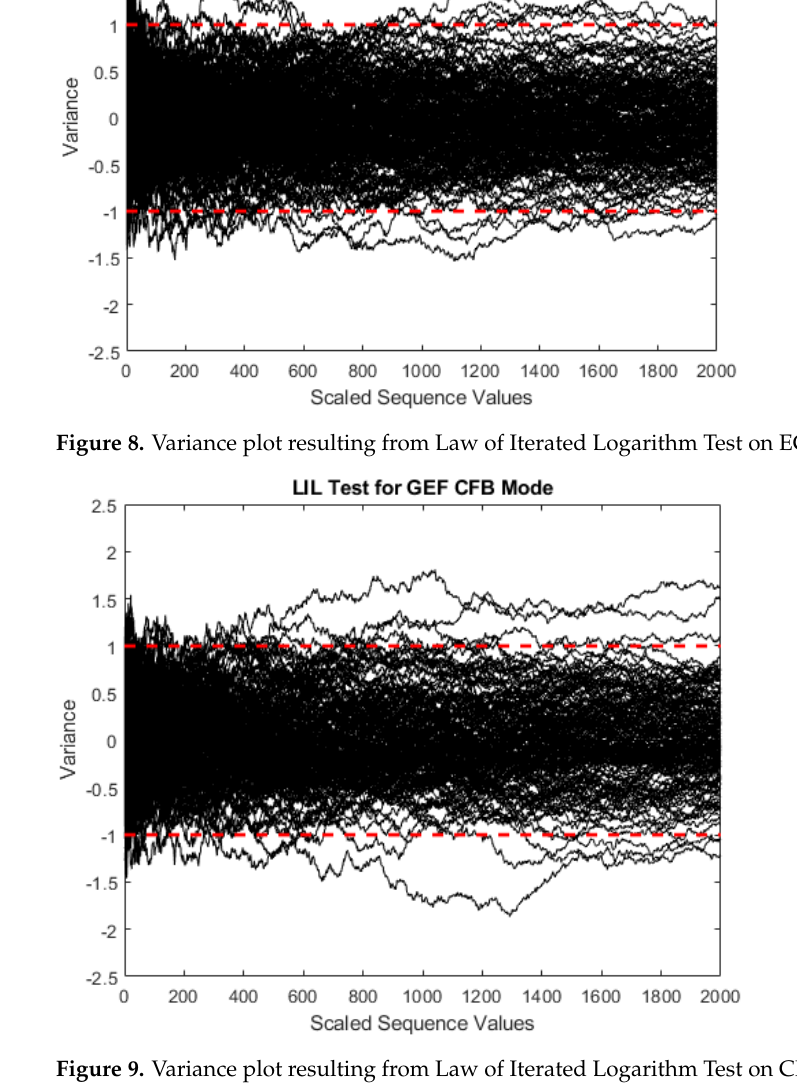
Figure 9. Variance plot resulting from Law of Iterated Logarithm Test on CFB